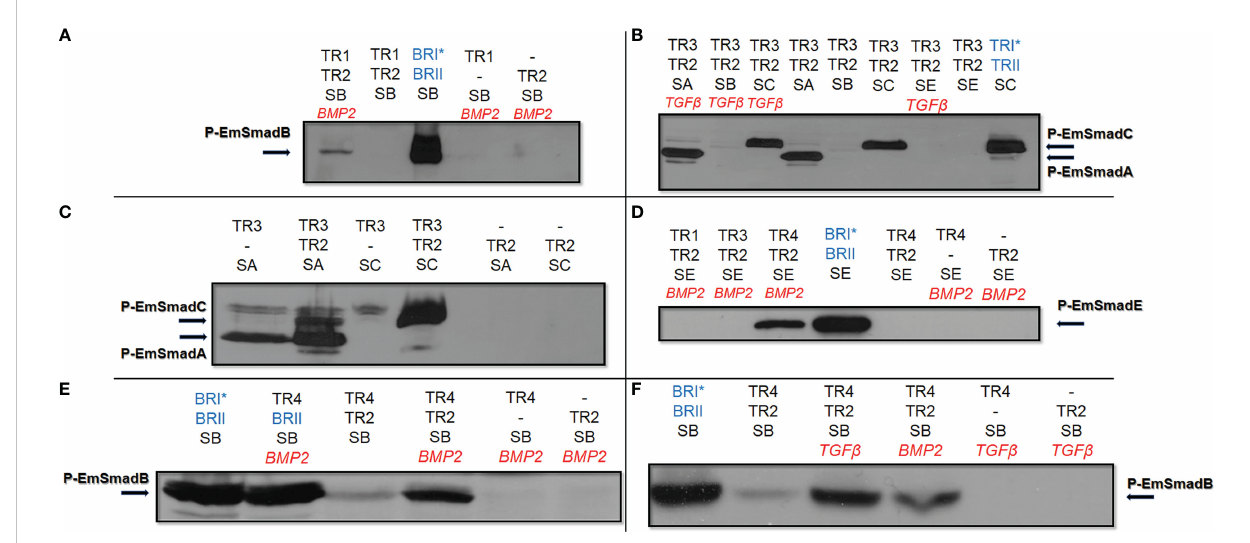
FIGURE 3 Functional activities of Echinococcus TGF b /BMP receptors. Echinococcus type I and type II TGF b /BMP receptors were co-expressed with Echinococcus R-Smads in HEK 293 T cells either with or without stimulation by exogneous human cytokines. Cell lysates were subjected to PAGE and Western blot analysis using phospho-speci fi c antibodies. Displayed are the results for EmTR1 and EmTR2 on EmSmadB (A) , EmTR3 and EmTR2 on EmSmadA and EmSmadC (B) , EmTR3 and EmTR2 on EmSmadA and EmSmadC (C) , all Echinococcus type I receptors with EmTR2 on EmSmadE (D) , as well as EmTR4 and EmTR2 on EmSmadB upon stimulation with exogenous BMP2 (E) or TGF b (F) . Human type II receptors for BMP (BRII) and TGF b (TRII) as well as constitutively activated forms of human type I receptors for BMP (BRI*) or TGF b (TRI*) were included as controls (shown in blue). Abbreviations for Echinococus receptors (in black) indicate EmTR1 (TR1), EmTR2 (TR2), EmTR3 (TR3), and EmTR4 (TR4), abbreviations for R- Smads are SA (EmSmadA), SB (EmSmadB), and SC (EmSmadC), and SE (EmSmadE). The addition of exogenous human BMP2 or TGF b is indicated in red. Arrows to the left and right indicate the phosphorylated R-Smad forms. In all cases comparative amounts of total R-Smads, as measured using an anti-Myc-tag antibody, were applied to the gel. Additional bands in (C, E) are background deriving from endogenously expressed Smads of HEK 293 T cells. Results show representative examples of experiments performed in triplicates. -, not